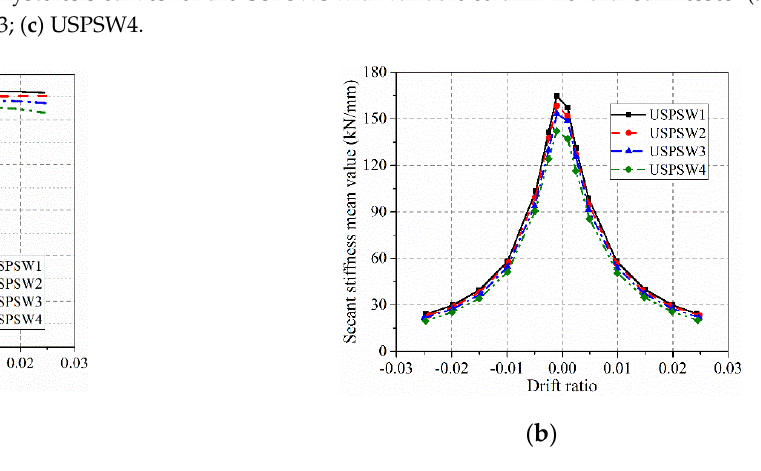
Figure 19. USPSW curves: ( a ) Envelope curves; ( b ) Secant stiffness reduction curves. The initial stiffness and secant stiffness with drift ratios of 0.4% and 2% for